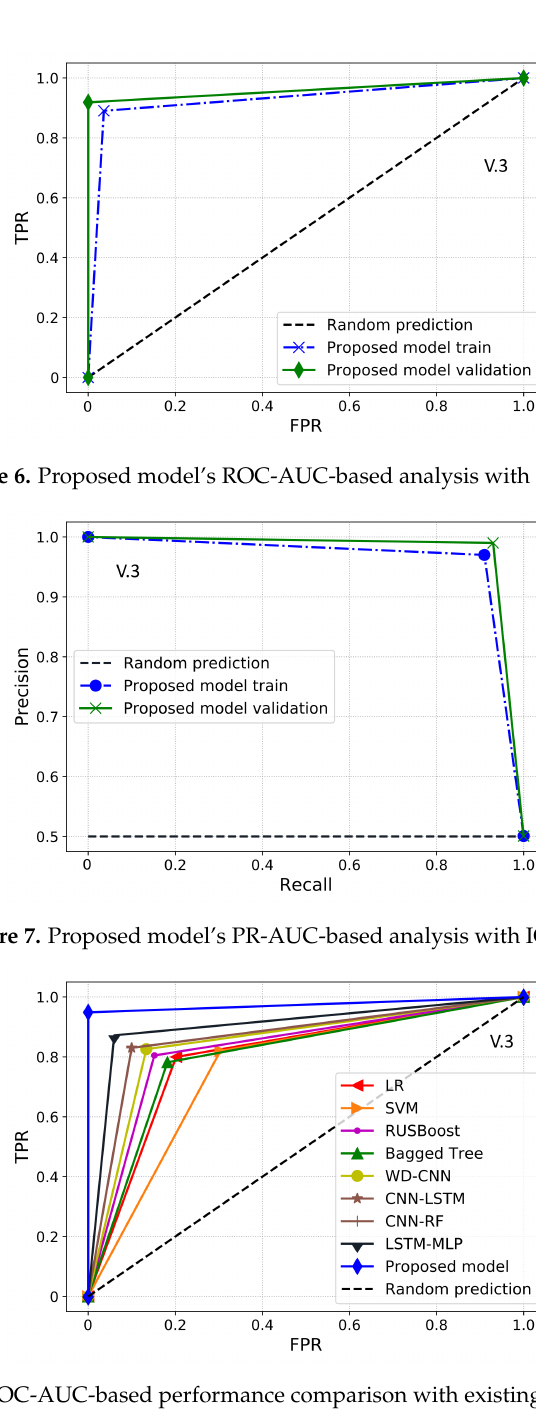
Figure 8. ROC-AUC-based performance comparison with existing